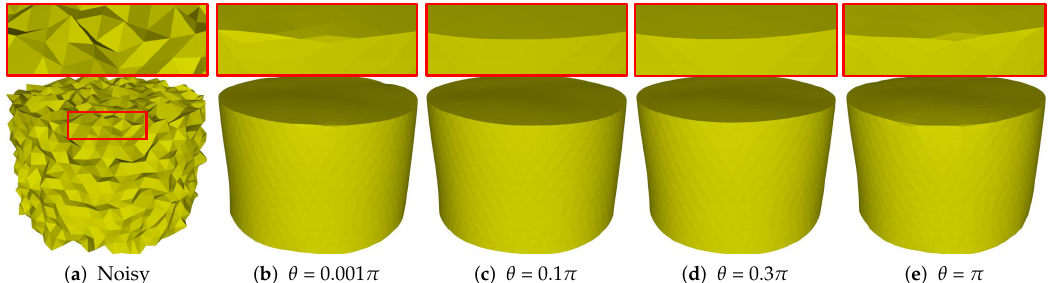
Figure 10. Denoising results for different θ (0.001 π , 0.1 π , 0.3 π , π ).